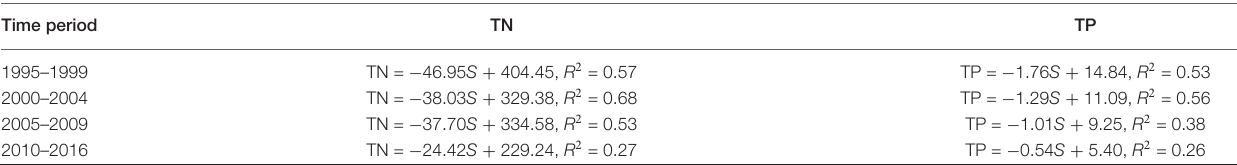
FIGURE 3 | Evaluation of the regression lines for the selected time periods for the area of the Rügen Lagoon chain for total nitrogen (A) and total phosphorus (B) for theupper 10 m of the water column; the fits were done in this case for a salinity range equal to or below